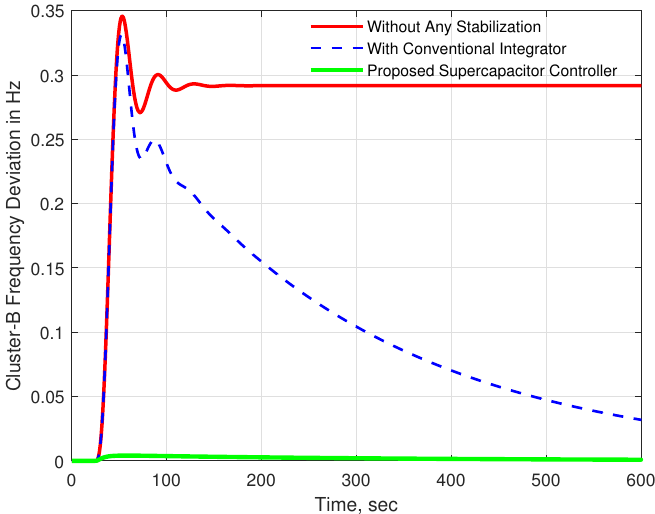
Figure 7. Frequency response for cluster B with 0.01 p.u. disturbance in cluster